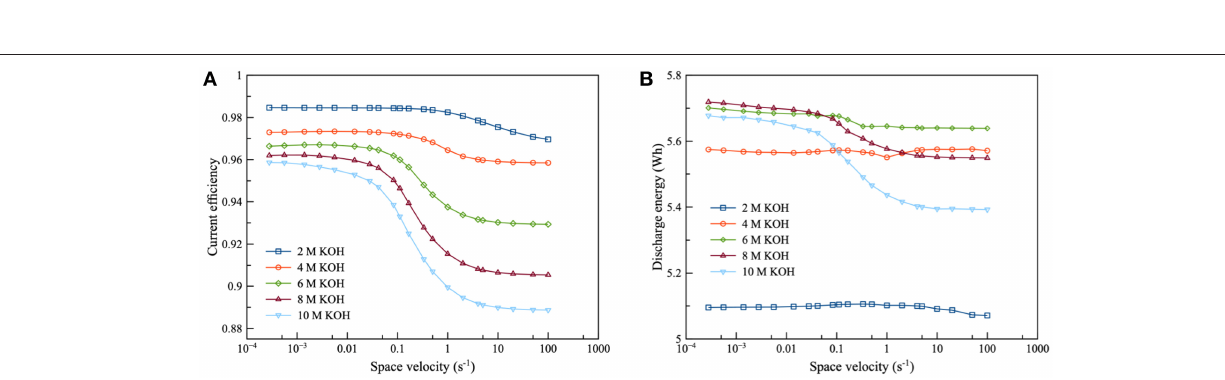
FIGURE 4 | Effects of KOH concentration on ZAFB using zincate ion initial concentration 0.2M and discharge current density of 100 mA/cm 2 : (A) current efficiency as a function of space velocity and (B) discharge energy as a function of space